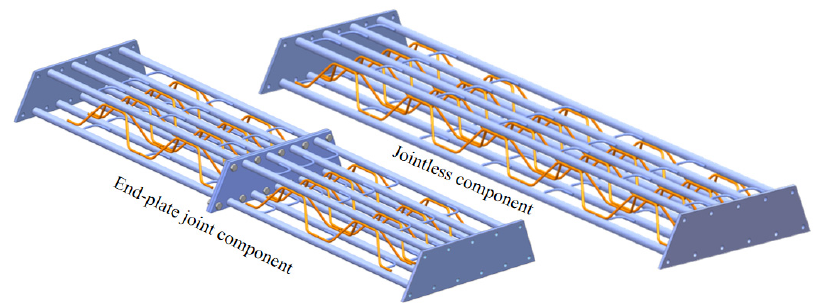
Figure 7. The end-plate joint component and jointless component.